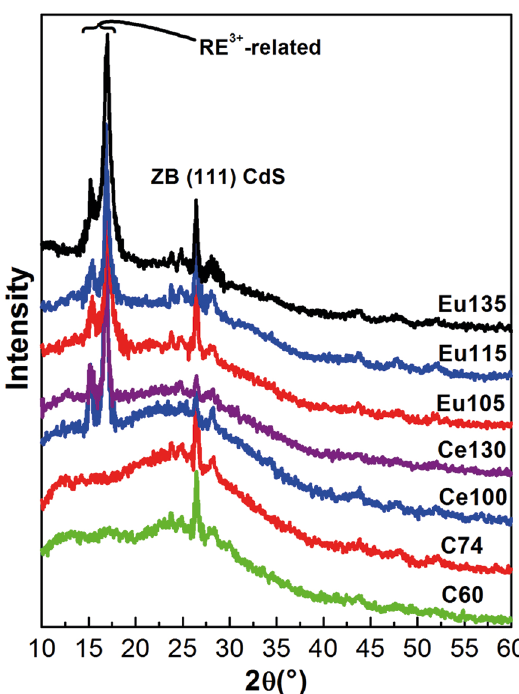
Figure 1. XRD diffraction patterns for CdS and CdS:RE 3+ nanofilms